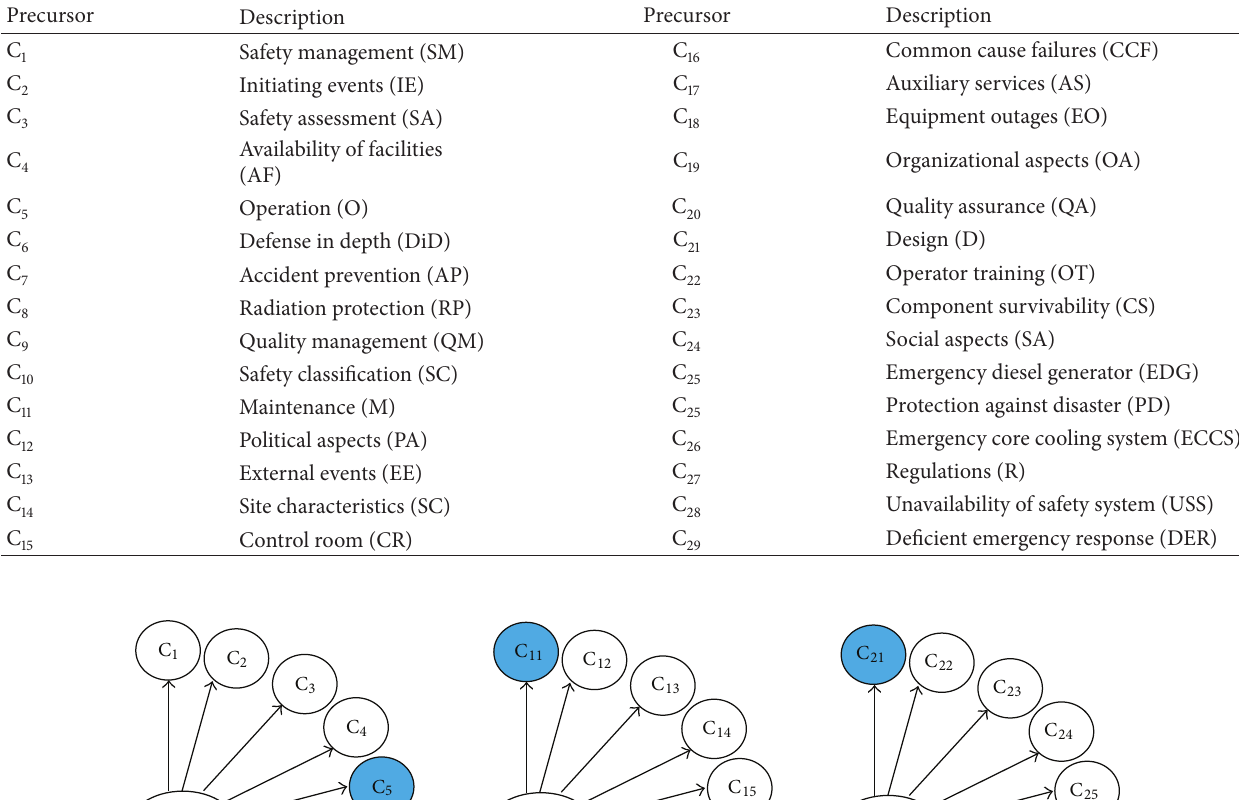
Table 4: List of all expected criteria.